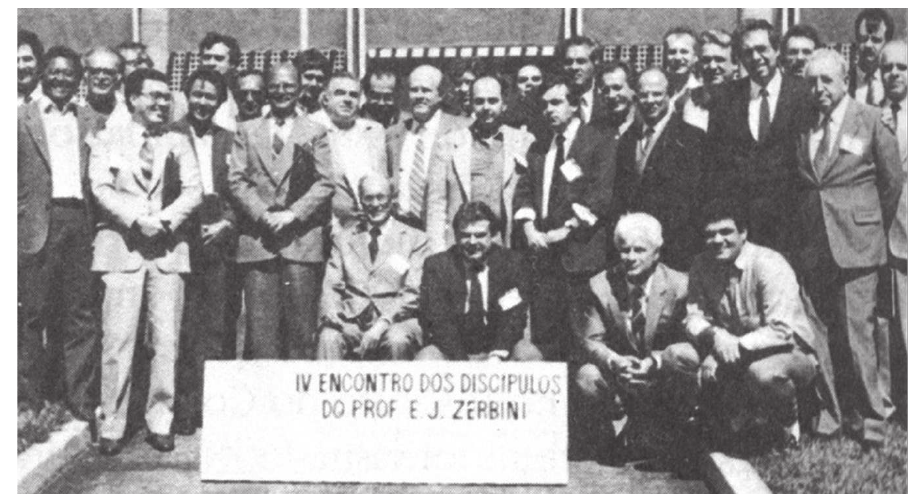
Fig. 13 – Foto dos participantes do Encontro dos Discípulos do Professor Zerbini, em